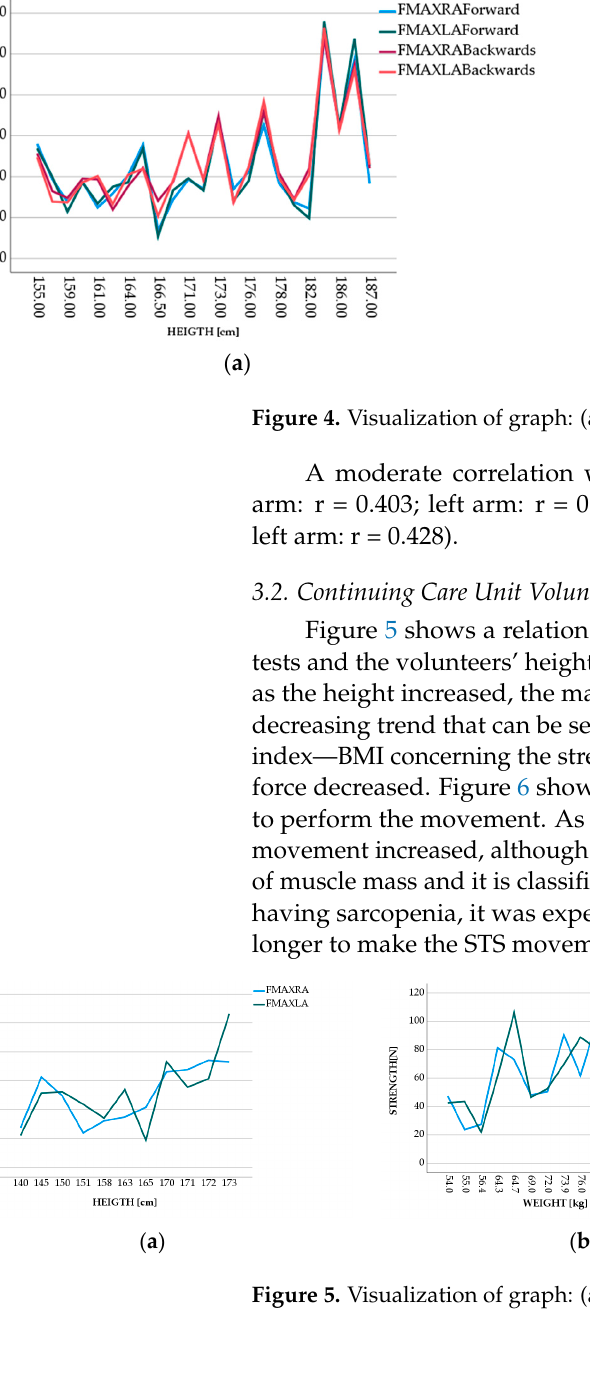
Figure 6. Visualization of graph SARC-F–time. 3.3. Healthy Young Volunteers vs. Continuing Care Unit Volunteers Although the volunteers from the continuing care unit needed the device more to support themselves than the healthy young volunteers did, the healthy volunteers were asked to use the developed device as support, i.e., the volunteer felt that the device was support to stand up without requiring too much strength from the lower limbs. So, it would be expected that the maximum average strength of the healthy and young volun- teers (both arms: F = 105 N) would be higher than that of the volunteer from the continuing care unit (right arm: F = 54 N; left arm: F = 56 N). The relation between the maximum strength from the right arm and the maximum strength from the left arm was higher in healthy and young volunteers. This fact is due to the non-existence of differences between the forces measured for each arm. 4. Discussion and Conclusions